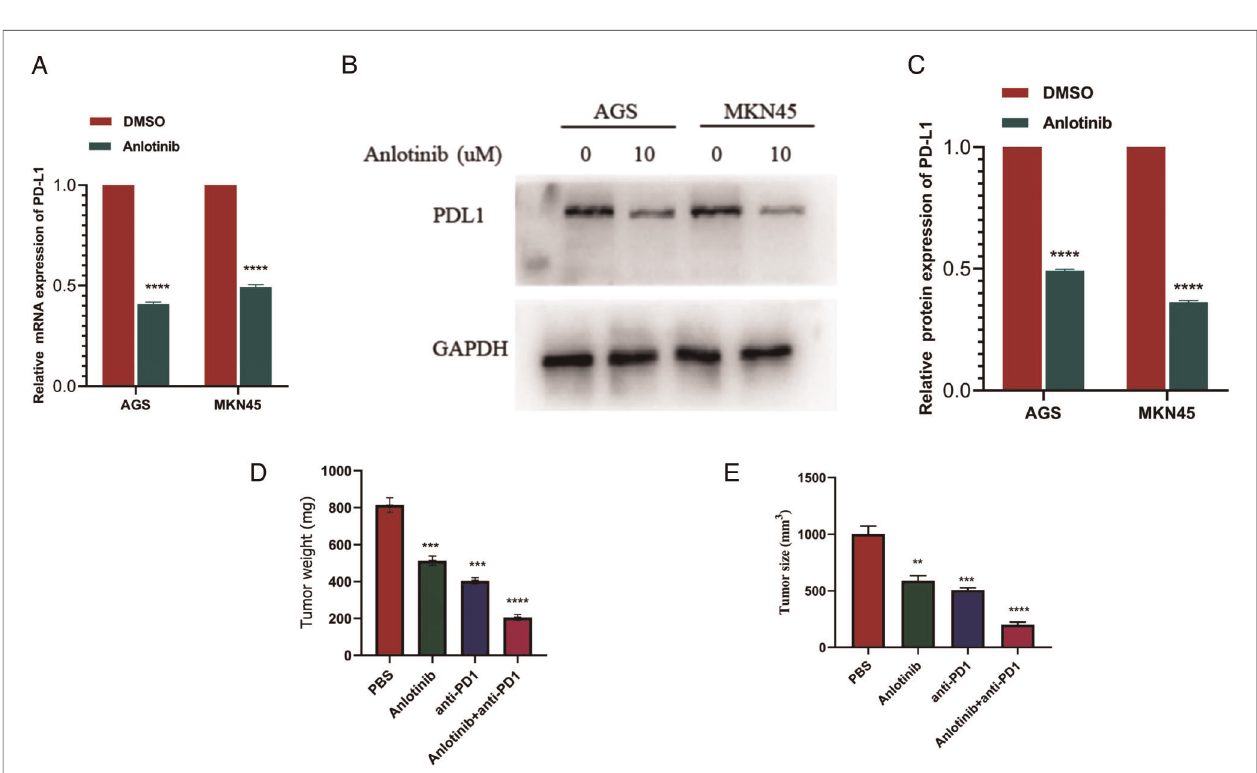
FIGURE 8 | Anlotinib combined with anti-PD-1 has a signi fi cant therapeutic effect on GC. ( A ) QRT- PCR results show that Anlotinib can signi fi cantly reduce the expression of PD-L1. ( B,C ) Western blotting experiment proved that Anlotinib can signi fi cantly reduce PD-L1 expression. ( D ) The relative weights of tumors were evaluated in C57BL/6 mice. ( E ) The relative tumor sizes were evaluated in C57BL/6 mice. *** P <0.001; **** P